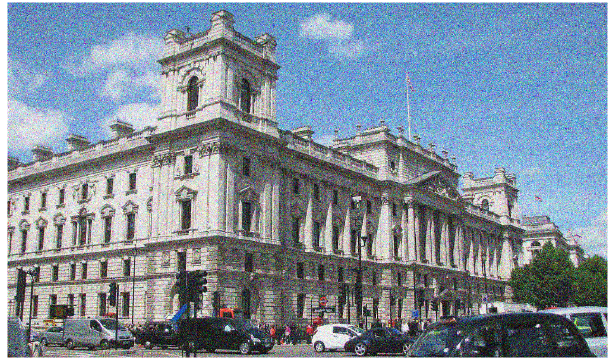
Figure 3. Example of visual snow. Patients with visual snow observe tiny dots in the entire visual field. The dots often resemble the “static” from a detuned analogue television because the dots “flicker on and off”. Classically, the dots are black/gray on a white background and white on a black background, but colors may